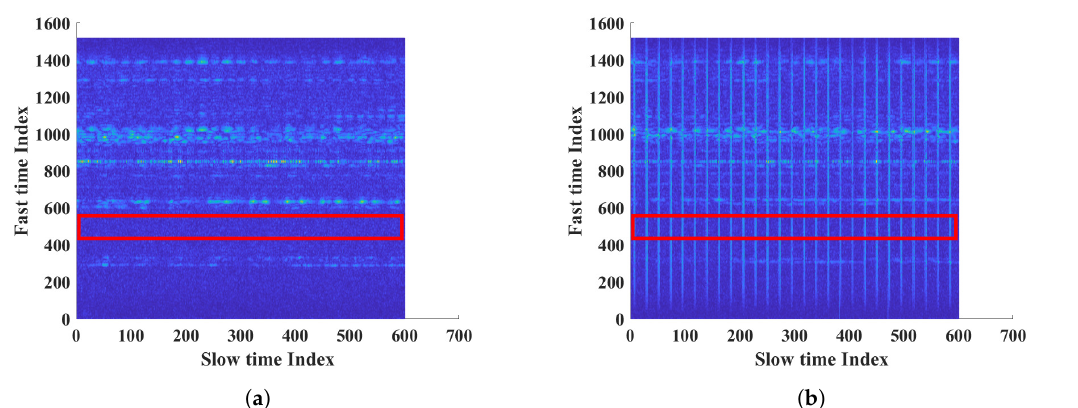
Figure 13. Measurement results of FMCW radar; ( a ) measurement without the FMCW interference, ( b ) measurement with the FMCW interference.